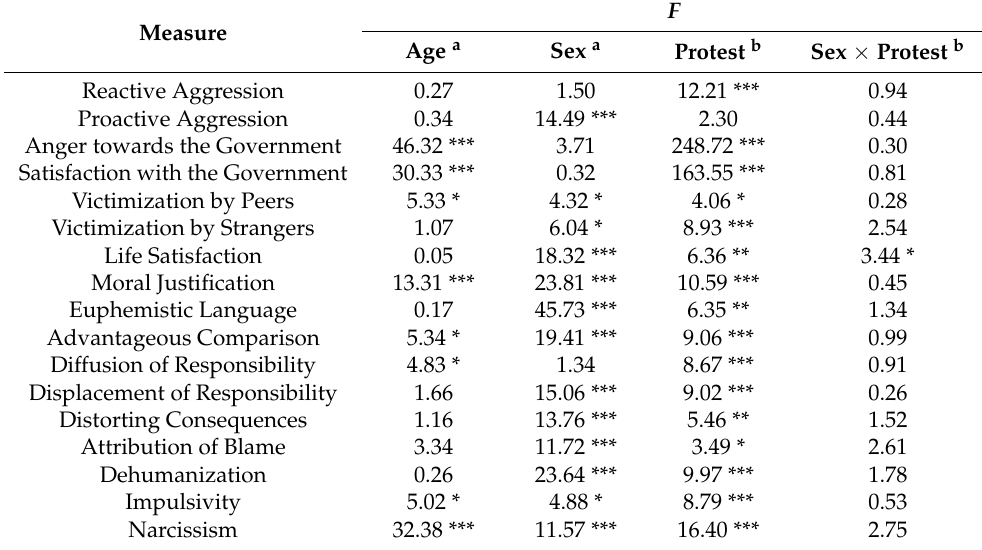
Table 4. Results of 2 × 3